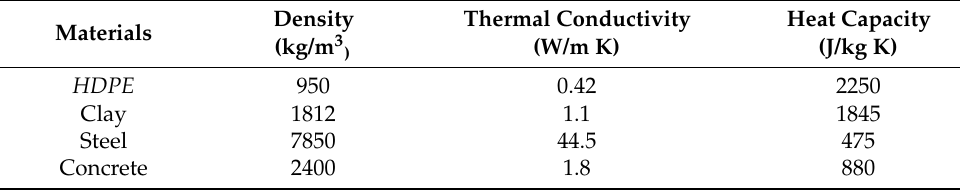
Table 2. Thermal characteristics of isotropic materials (Obtained from Gashti et al.